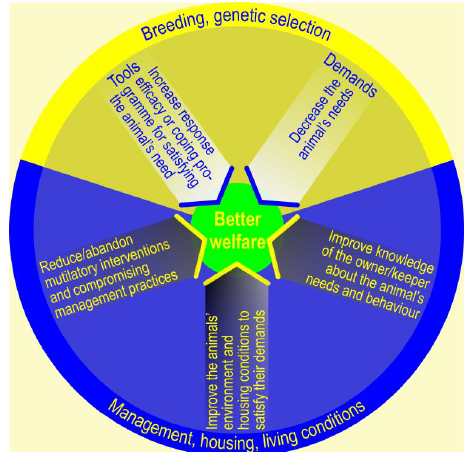
Figure 2. Strategies for improving animal welfare (inspired by [110]). Improving the animal’s tools (abilities) to cope efficiently with its environment or decreasing the animal’s demands (needs) via breeding programs and genetic selection are goals of ongoing activities. In particular, the strategy of reducing the animal’s demands by using genetic selection procedures is subject to ethical discussions [112,113]. Alternatively, one may reduce or abandon mutilating procedures, improve the animal’s housing conditions, and improve the knowledge of owners/keepers/stockmen with respect to the animal’s needs and demands. In particular, with respect to management, housing, and living conditions, animal welfare scientists and veterinarians should deploy their expertise, give (un)solicited advice, and assume an active role in the welfare discussion (see also Figure 3).